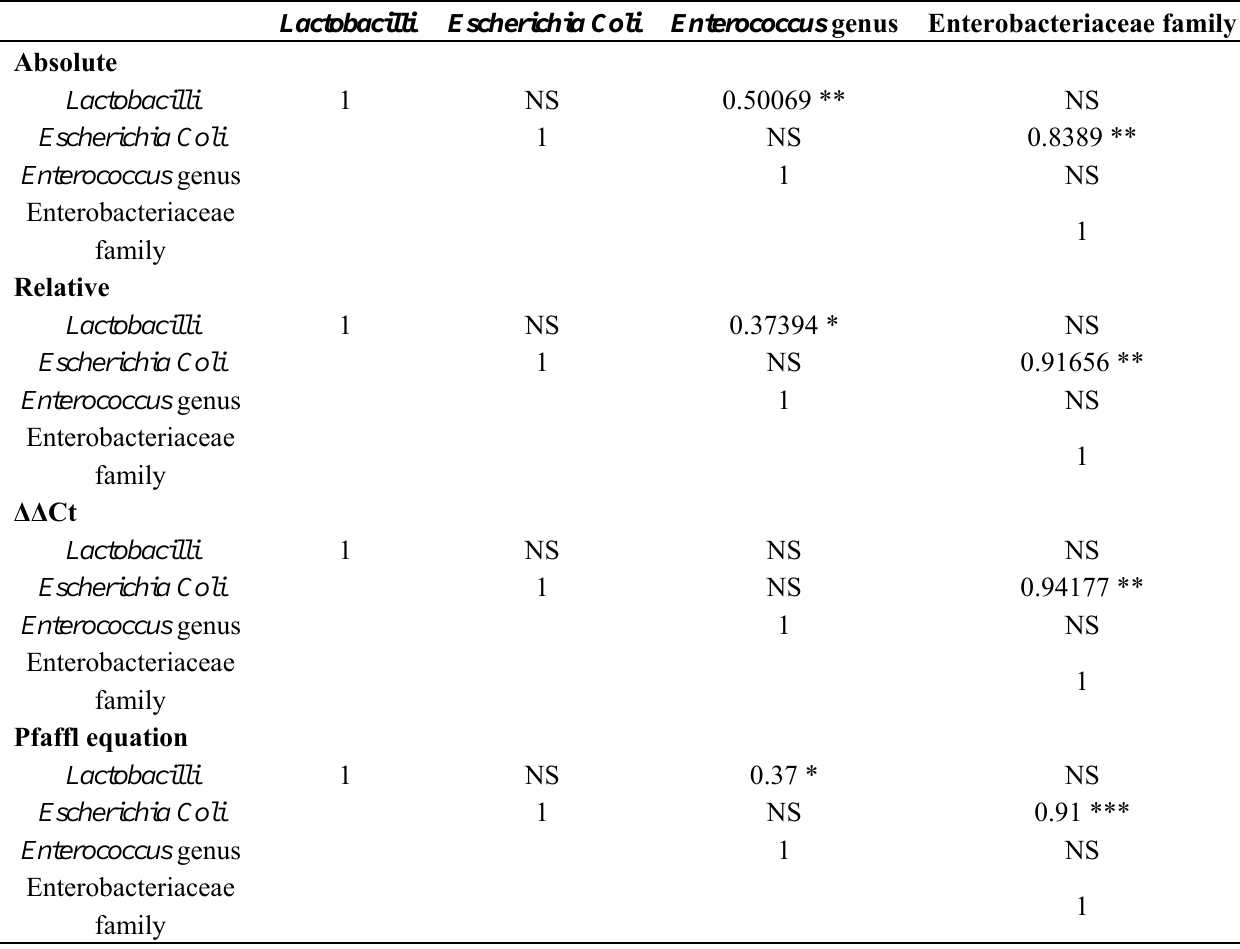
Table 4. Correlation coefficients between bacteria groups expressed based on different